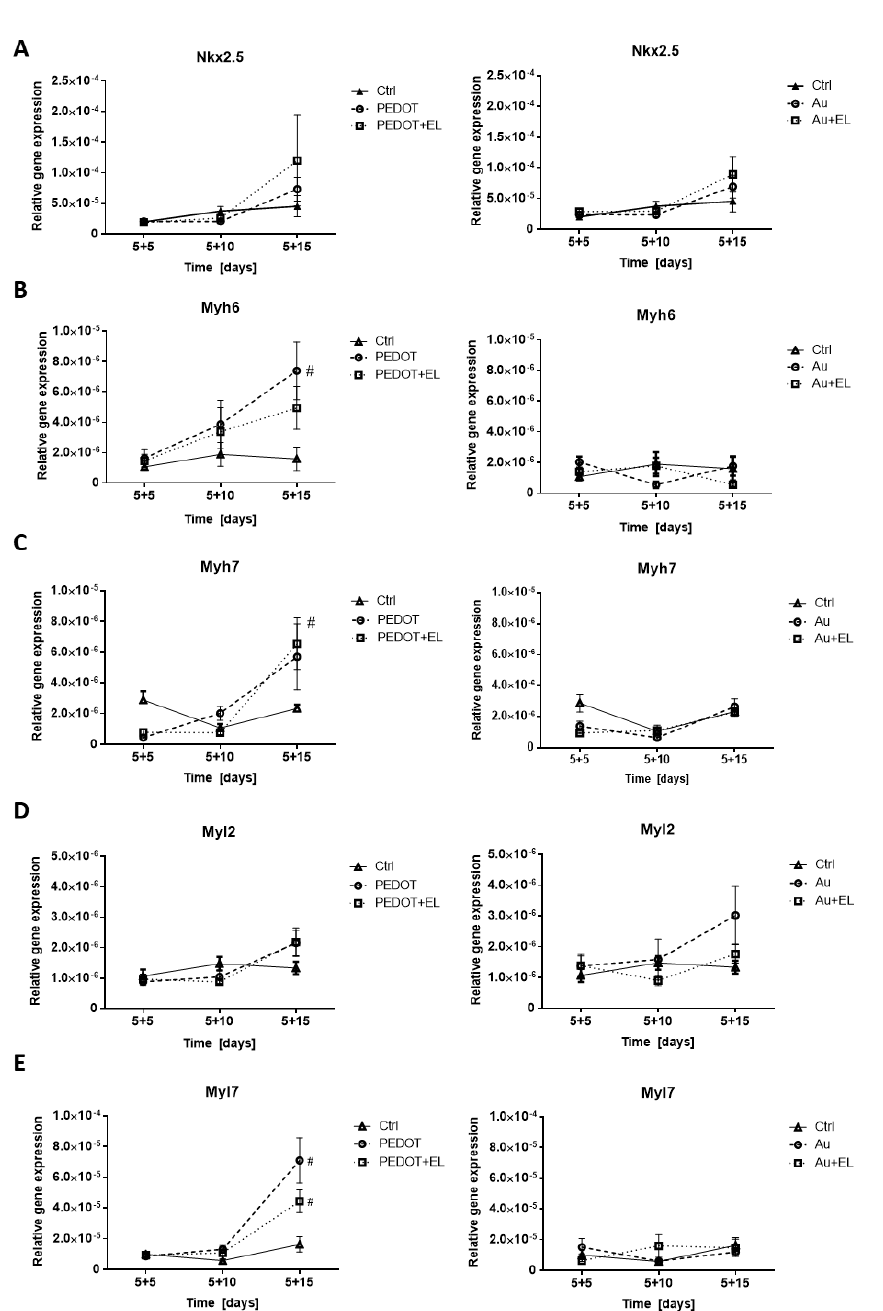
Figure 4. The effect of electrostimulation on expression cardiomyogenesis markers: Nkx2.5,